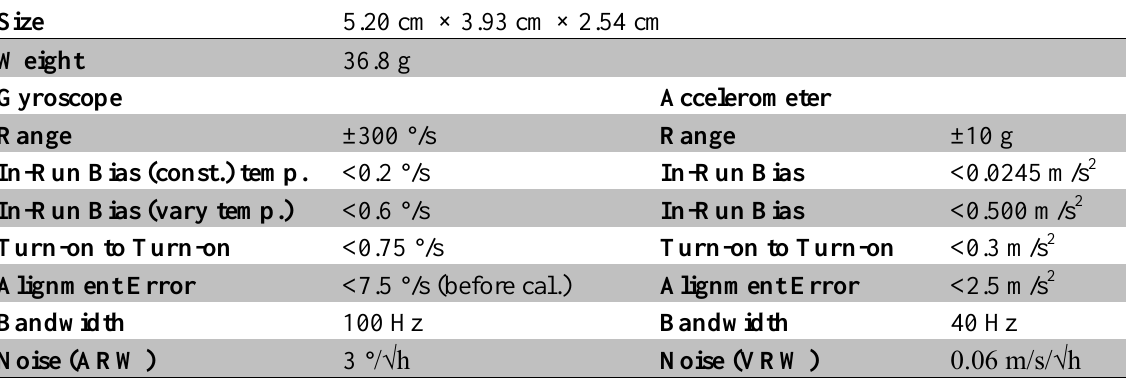
Table 1. Manufacturer specifications for Crista